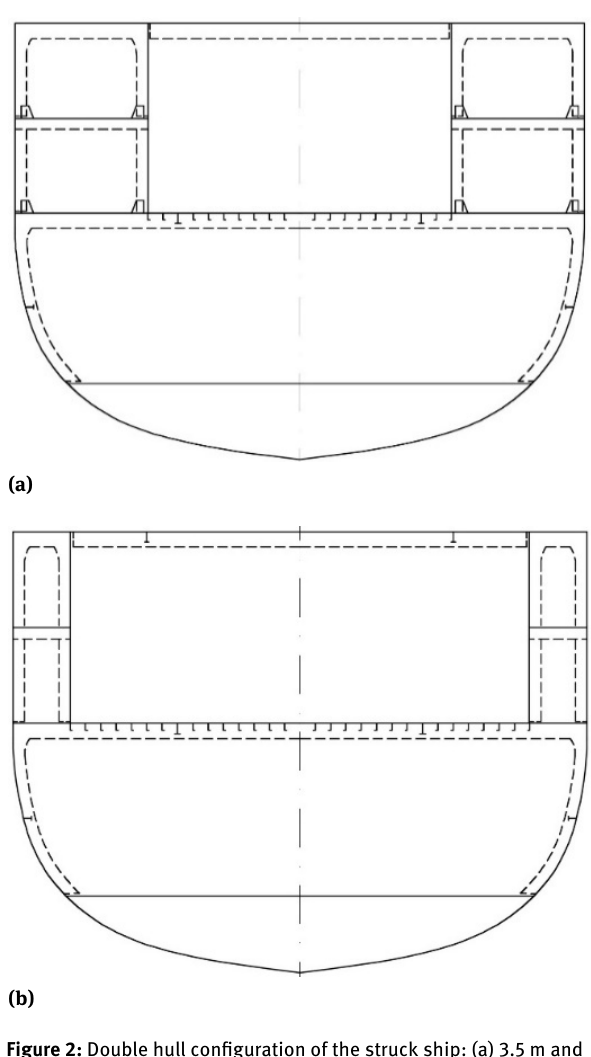
Figure 2: Double hull configuration of the struck ship: (a) 3.5 m and